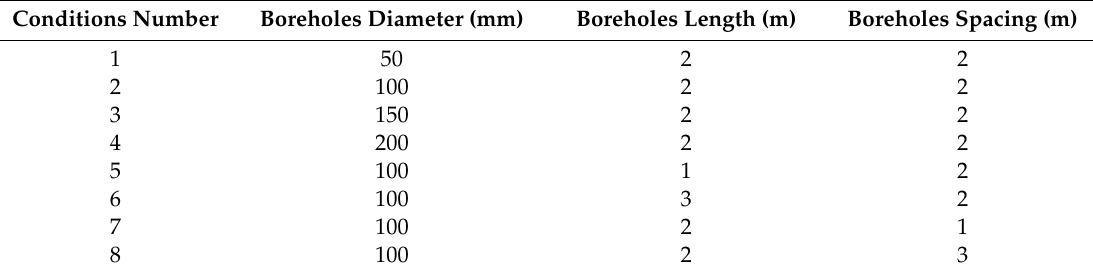
Table 2. Parameters of simulated conditions.